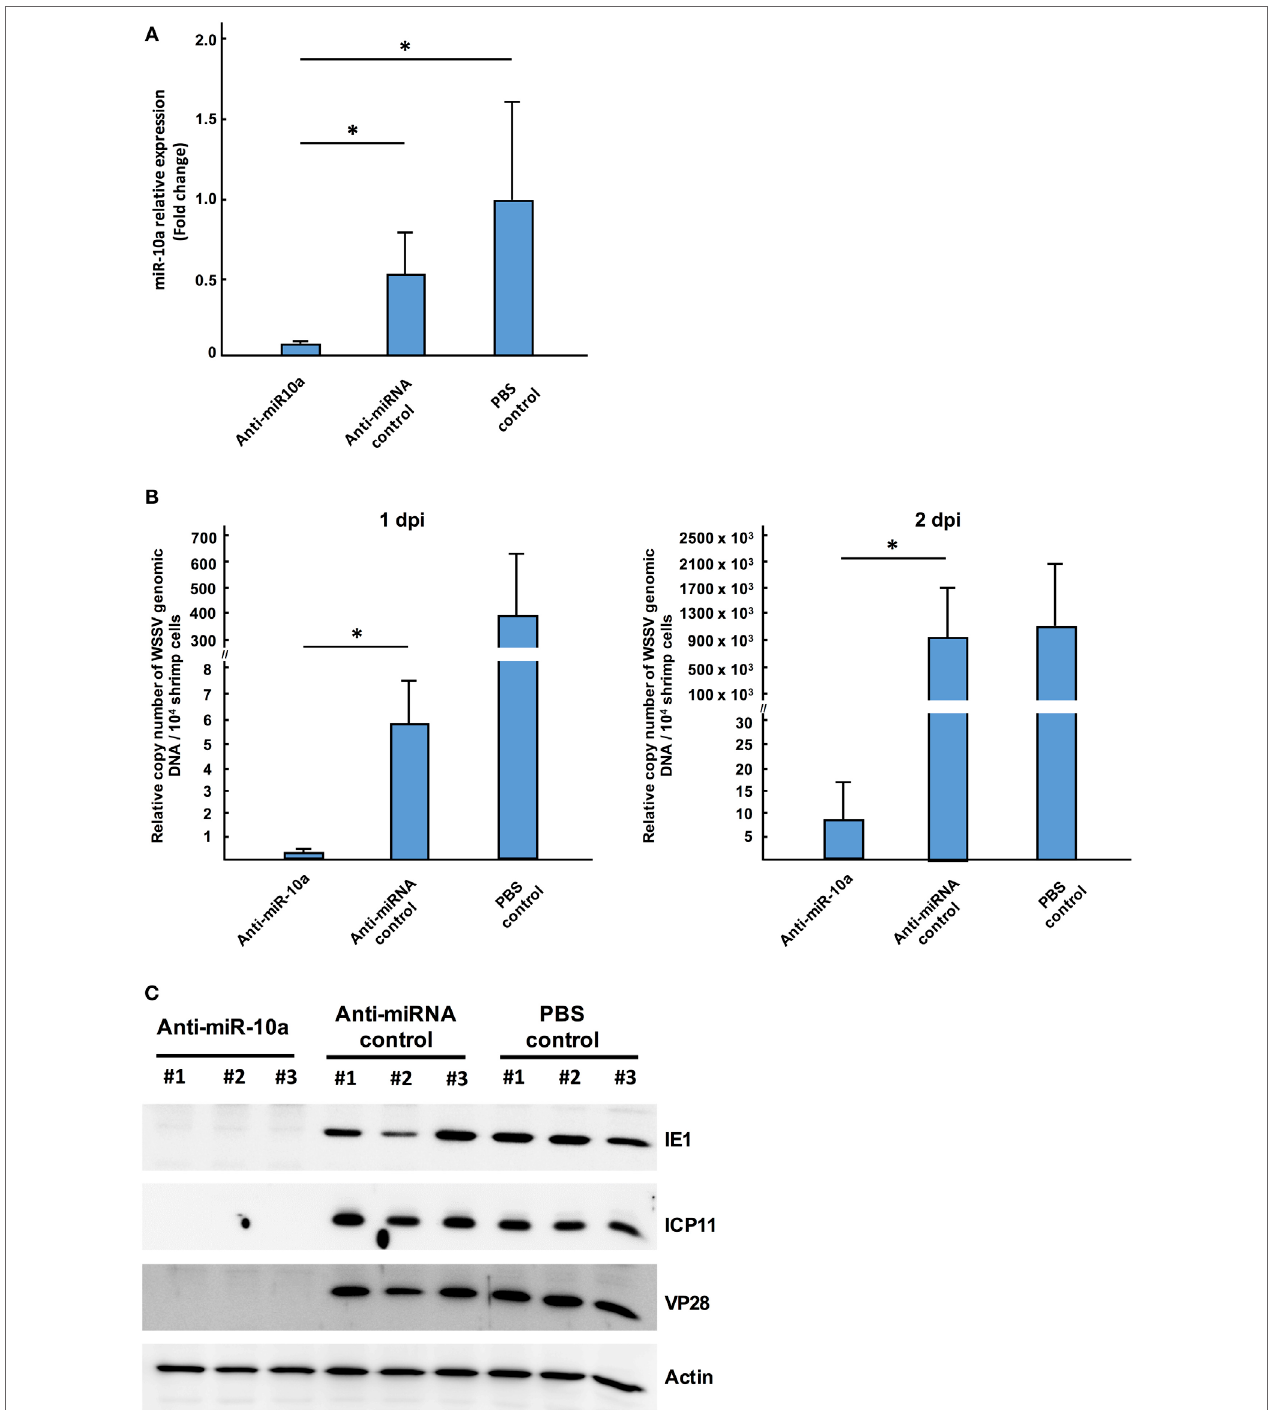
FigUre 2 | The role of host miR-10a in white spot syndrome virus (WSSV)-infected shrimp. Shrimp ( L. vannamei ; mean weight 7 g) were injected simultaneously with WSSV and control anti-miRNA inhibitor (1 nmol/shrimp); WSSV and anti-miR-10a inhibitor (1 nmol/shrimp); WSSV and phosphate-buffered saline (PBS). (a) Real-time PCR analysis of miR-10a expression 1 day after the injection of anti-miR-10a inhibitor. miR-10a expression levels were determined in cDNA derived from shrimp pleopods. 2 −ΔΔ Ct was used to analyze the expression of miR-10a, and results are presented relative to the expression of shrimp U6. Values shown are the mean ± SD from four shrimp at each time point (* p < 0.05 by Student’s t -test). (B) An IQ REAL ™ WSSV Quantitative System kit was used to determine the WSSV copy number in shrimp pleopods. Values shown are the mean ± SD from four shrimp at each time point (* p < 0.05 by Student’s t -test.) (c) Specific anti-IE1, anti-ICP11 and anti-VP28 antibodies were used to detect WSSV protein levels in shrimp stomach of anti-miR-10a inhibitor treated shrimp, non-specific microRNA inhibitor treated shrimp, and PBS-injected shrimp. Shrimp actin was detected with anti-actin antibody as internal